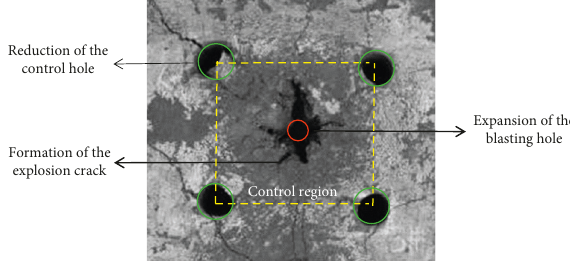
Figure 7: Crack morphology of soft coal (Single-hole blasting model).